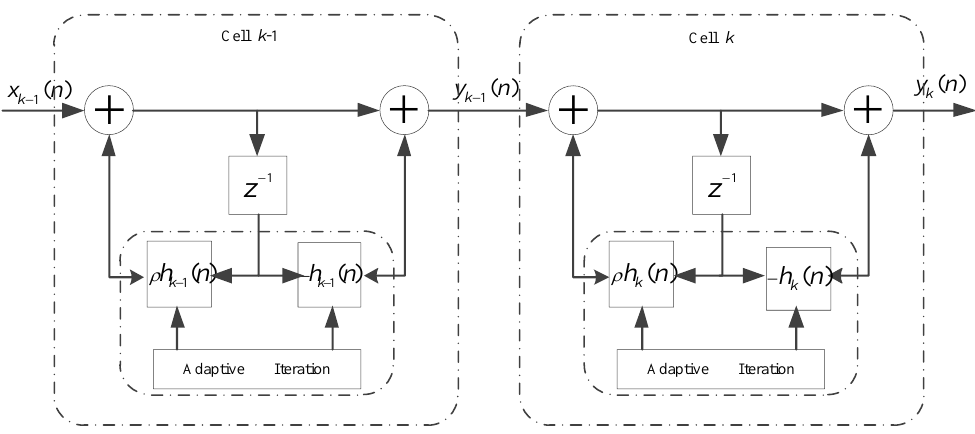
Figure 3. Implementation of linear cascaded complex-coefficient high order adaptive notch filter.